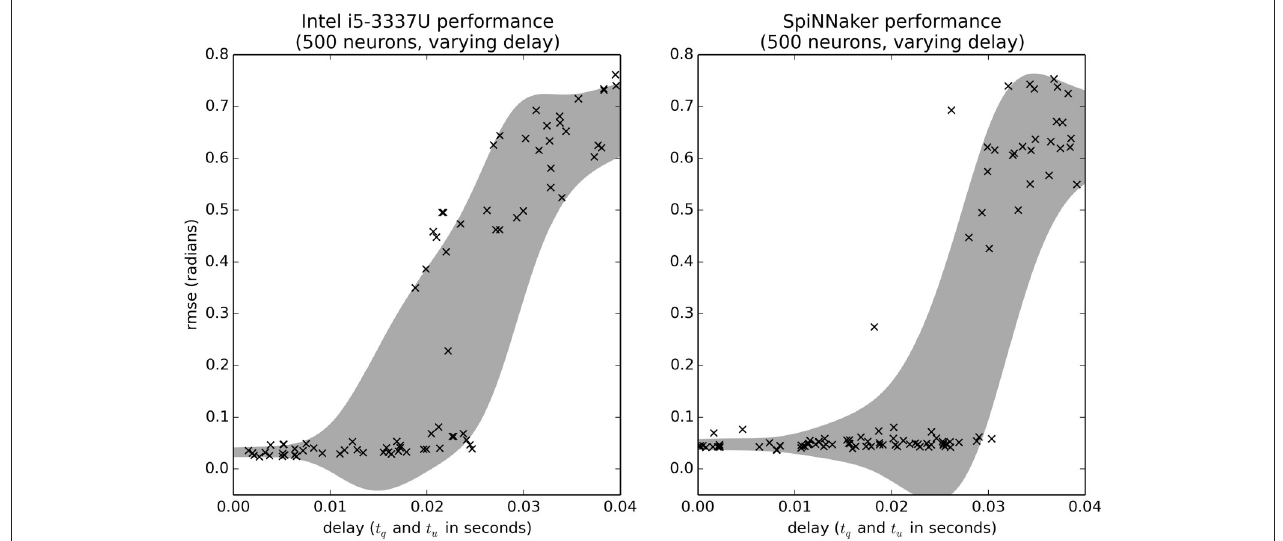
FIGURE 8 | Benchmark results comparing the effects of communication delay for the CPU and SpiNNaker systems. The delays t q and t u are randomly varied. Shaded area is the mean plus or minus one standard deviation, smoothed with a Gaussian kernel of σ = 0.005 .